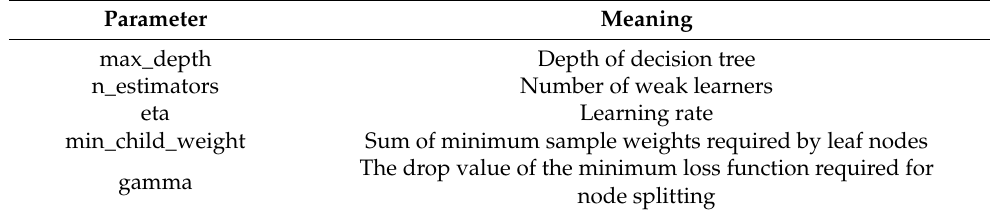
Table 7. Hyper parameters of XGB and their